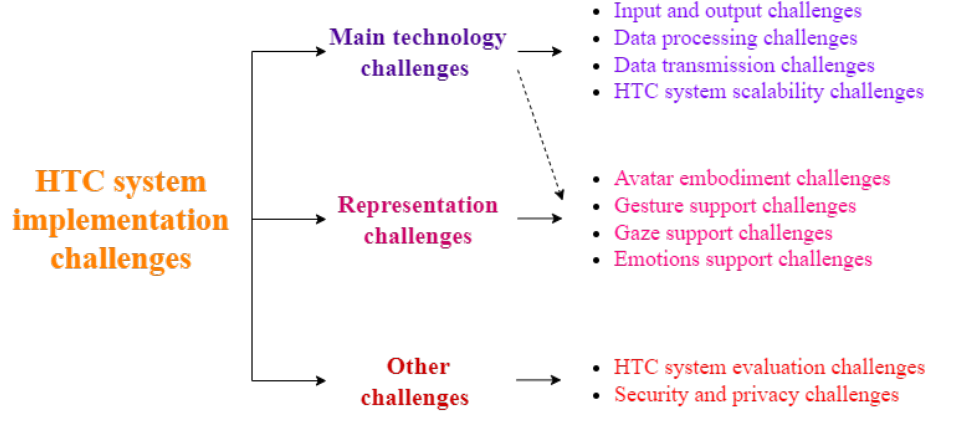
Figure 4. HTC system challenges